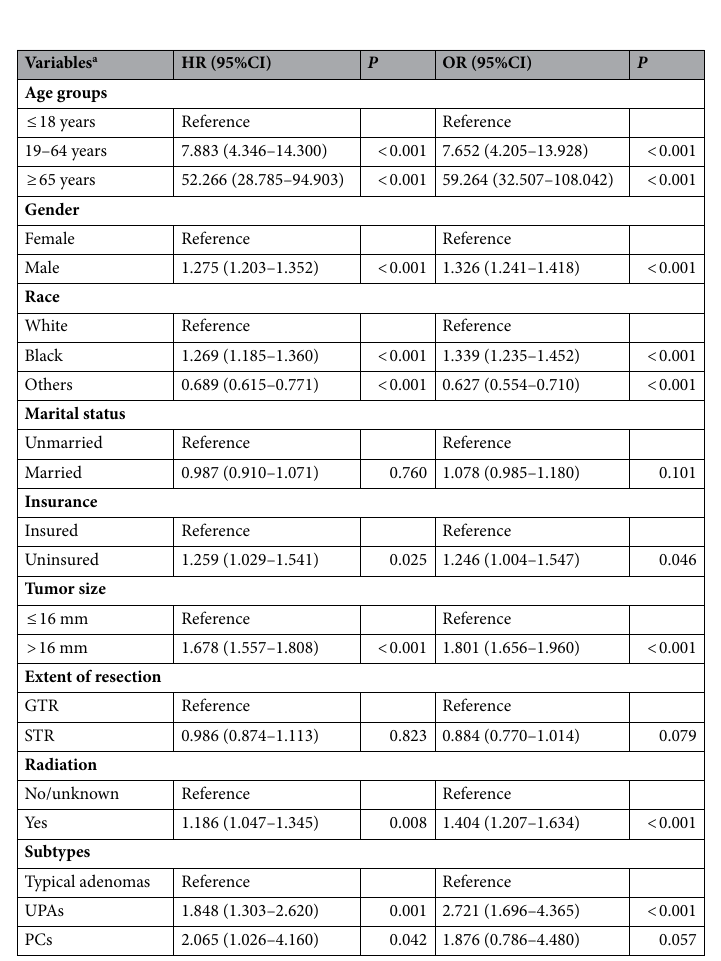
Table 4. Results of multivariate regression for demographic and clinical variables associated with overall survival. HR Hazard ratio, OR Odds ratio, GTR Gross total resection, STR Subtotal resection, UPAs Uncertain behavior pituitary adenomas, PCs Pituitary carcinomas. a Unknown data were removed from regression model due to